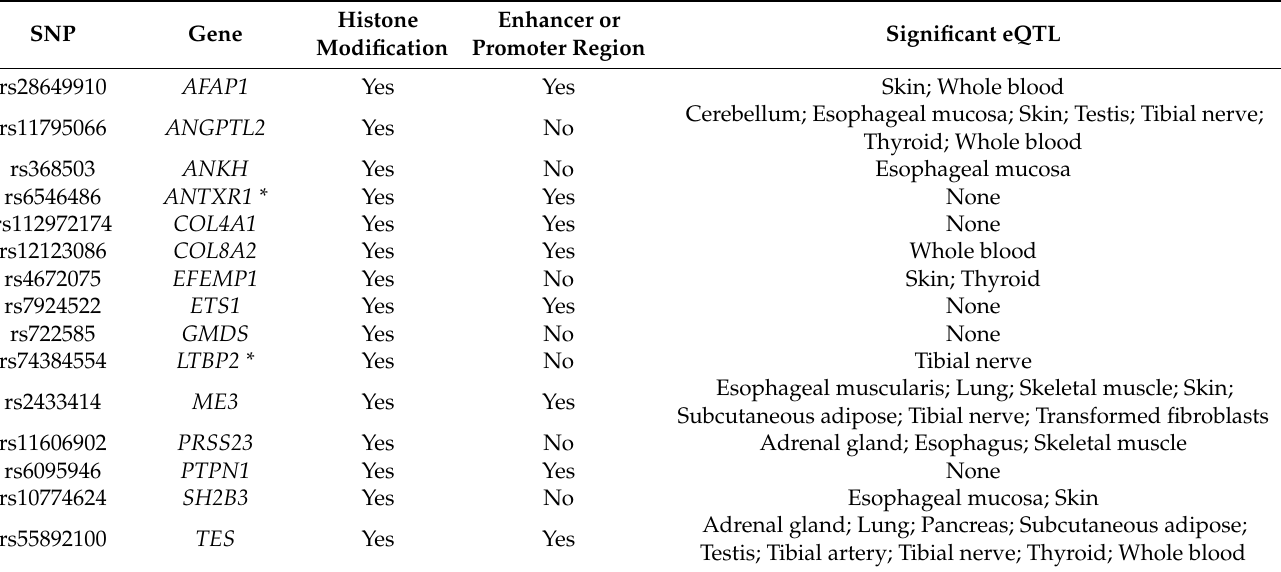
Table 6. Genomic Location of Intraocular Pressure (IOP)-Associated Single Nucleotide Polymorphisms (SNPs) and Expres- sion Quantitative Trait Loci (eQTL) for IOP-Associated Gene/SNP